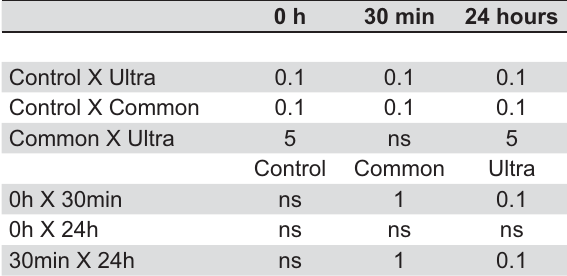
Table 2- (cid:11)(cid:17)(cid:30)(cid:3)(cid:4)(cid:12)(cid:13)(cid:3)(cid:10)(cid:11)(cid:15)(cid:19)(cid:21)(cid:13)(cid:6)(cid:5)(cid:12)(cid:14)(cid:19)(cid:26)(cid:14)(cid:11)%(cid:10)(cid:5)(cid:12)(cid:8)(cid:10)(cid:27)(cid:11)?(cid:12)(cid:4)(cid:28)(cid:11)(cid:6)(cid:11)E(cid:5)(cid:30)(cid:14)(cid:16)(cid:6)(cid:3)(cid:7)H(cid:6)(cid:3)(cid:3)(cid:12)(cid:14)(cid:11) statistical